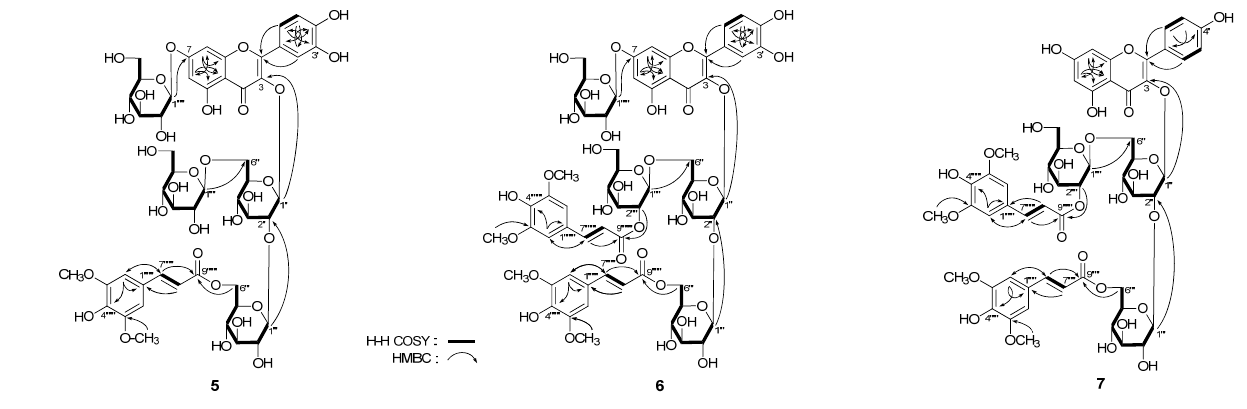
Figure 3. The main 1 H 1 H COSY and HMBC correlations of 5 – 7